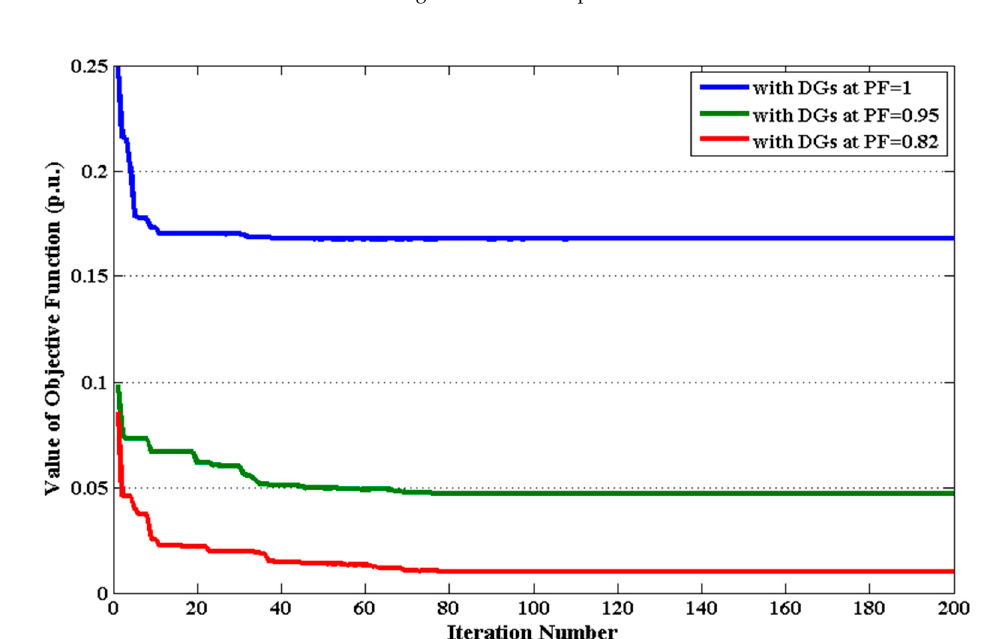
Figure 12. Convergence characteristics for Case 2 of the IEEE 69-bus system using QODELFA.